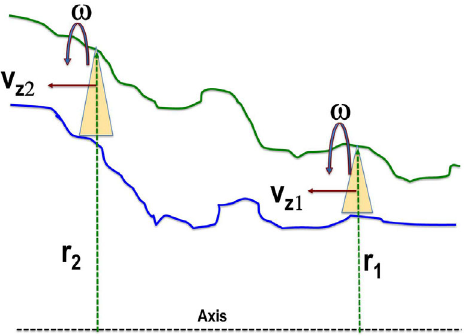
FIG. 5. Illustration of the concept for using a shaped cathode in HEC-CED to achieve a uniform film thickness on an arbitrarily shaped